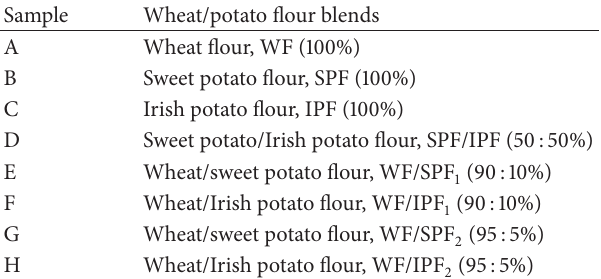
Table 1: Wheat and potato flour blends for bread making.